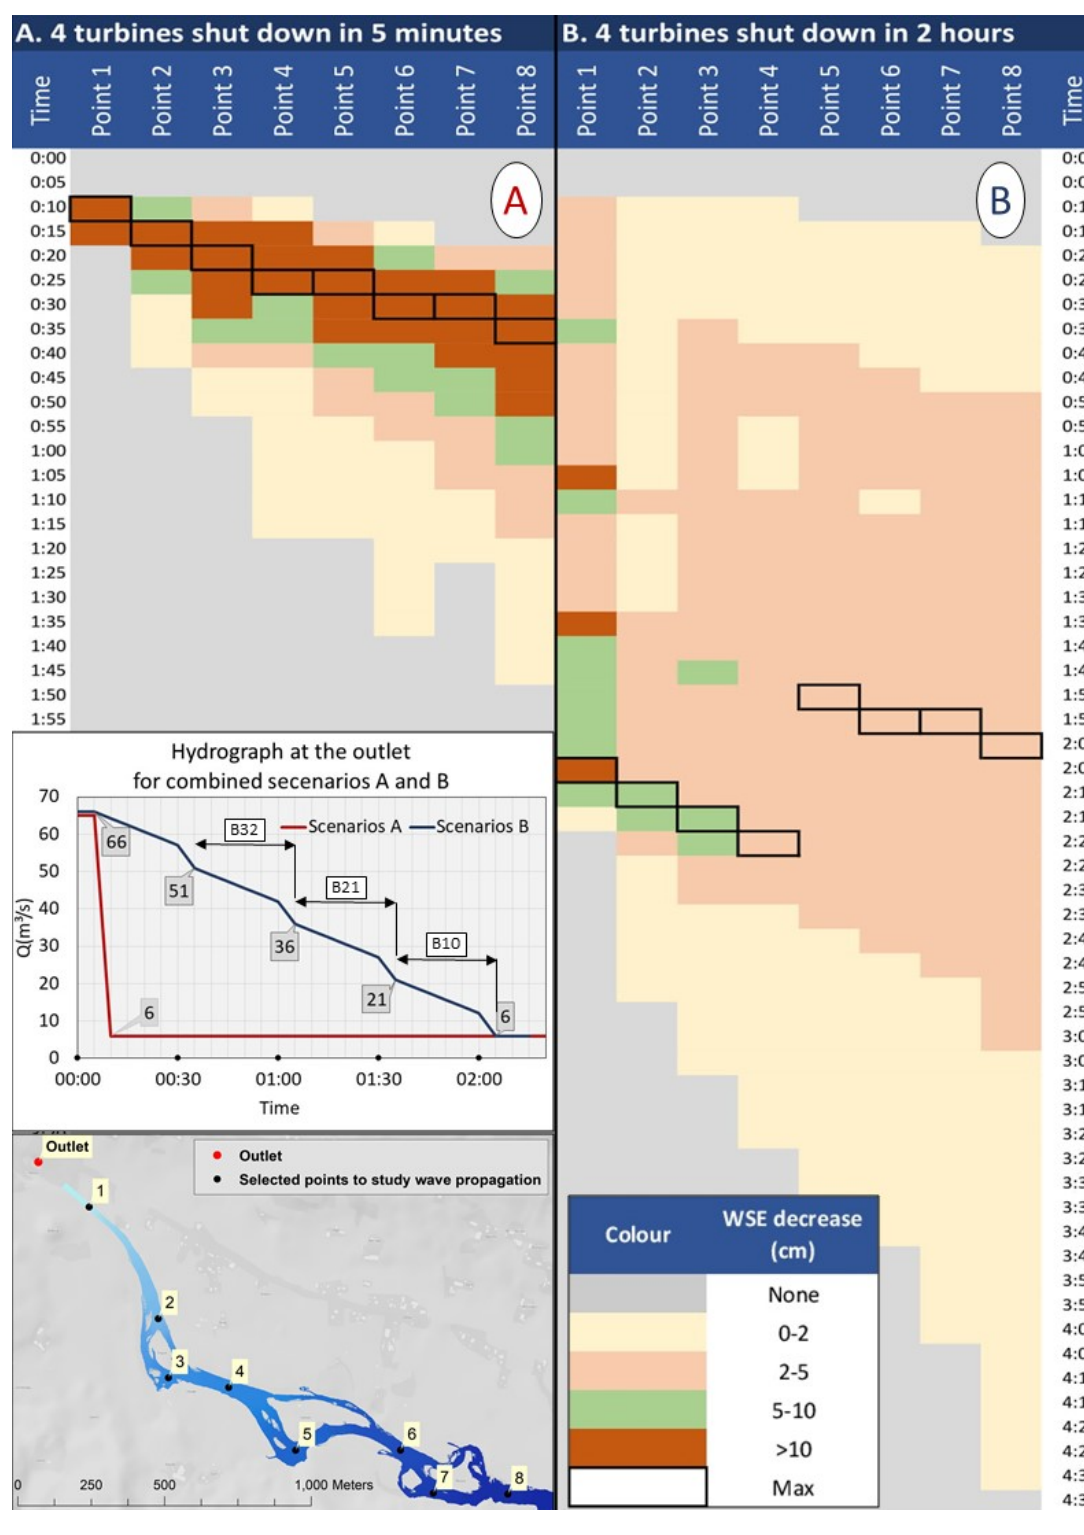
Figure 8. Water surface elevation (WSE) for the 10 selected points along Storåne after a discharge variation from 66 to 6 m³/s in 5 min ( left ) and 2 h (30 min per turbine) for the alternative operation procedure ( right ). The black squares indicate when the maximum elevation variation occurs in each specific point.